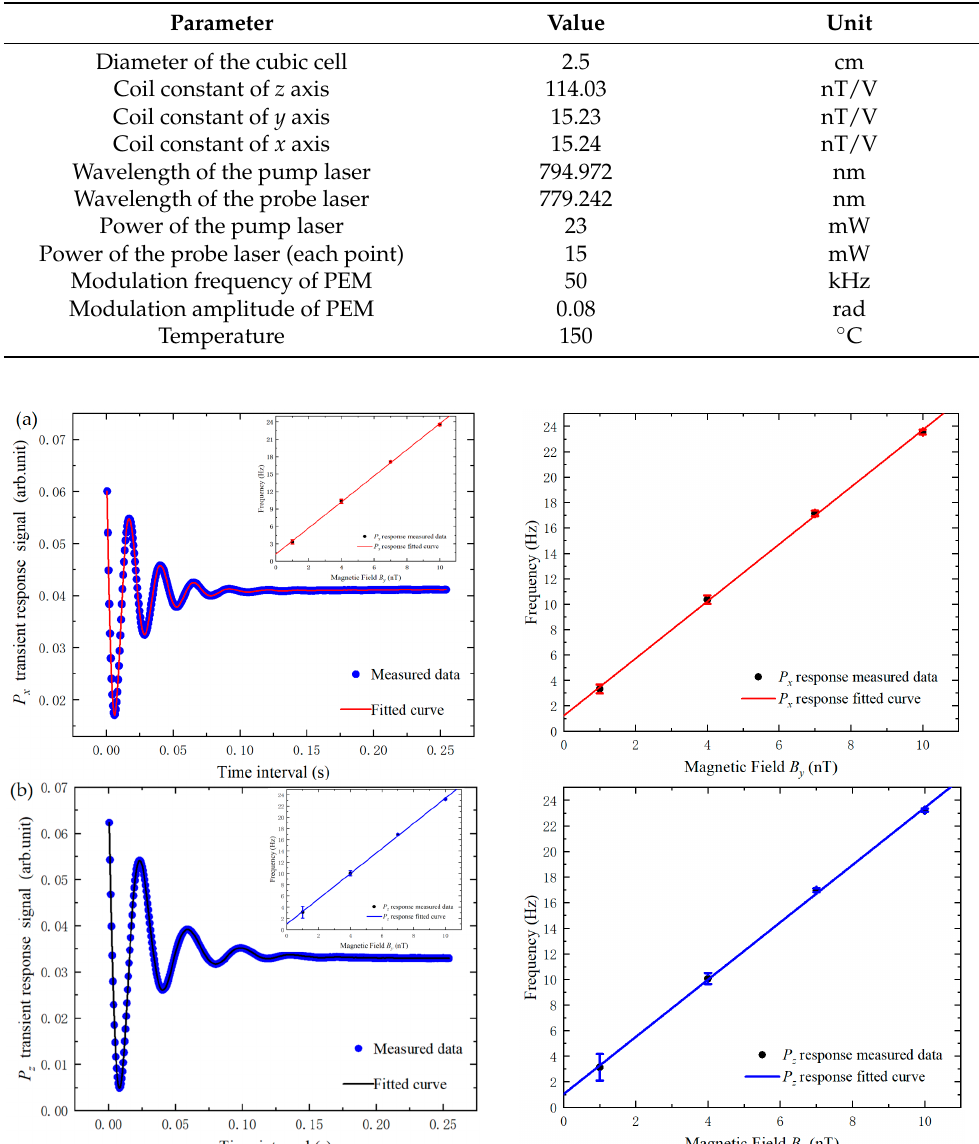
Table 2. Parameters of Measurement System.